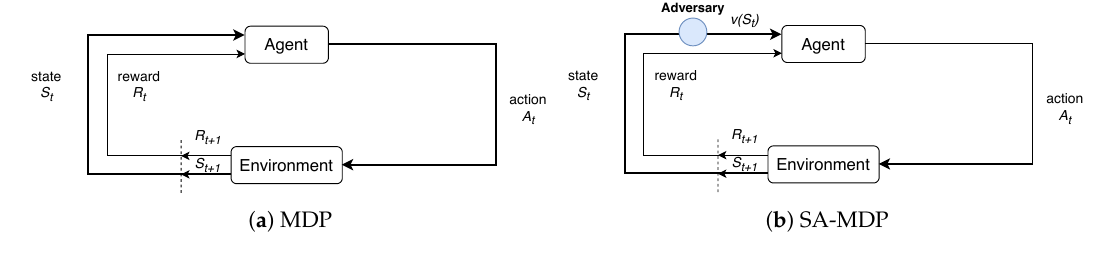
Figure 1. The diagrammatic sketchs of MDP and